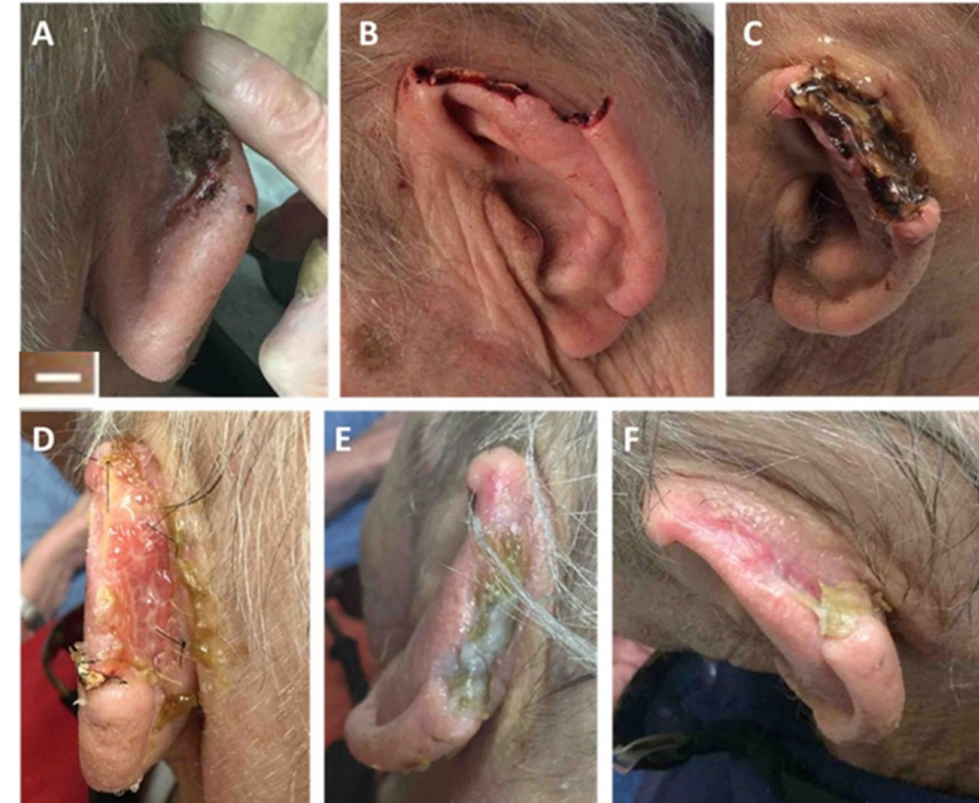
Figure 7. A representative Post-Mohs wound that healed over time following treatment with the syn- thetic hybrid-scale fiber matrix. ( A ) Squamous cell carcinoma (SCC) at the left posterior helix, ( B ) the resultant Mohs defect post-micrographic surgery, and ( C ) 2 weeks, ( D ) 3 weeks, ( E ) 5 weeks, and ( F ) 7 weeks after application of the synthetic hybrid-scale fiber matrix. Complete re-epithelialization was observed at 7 weeks. Scale bar represents 1